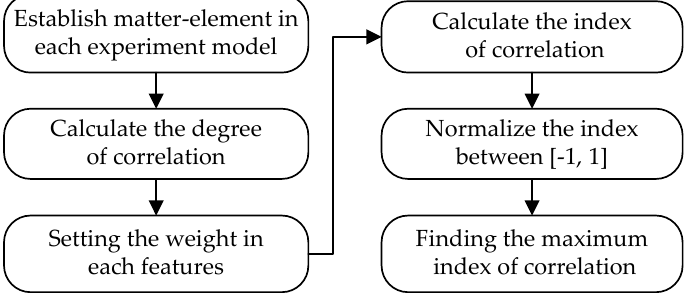
Figure 8. Flow chart of the extension recognition method.